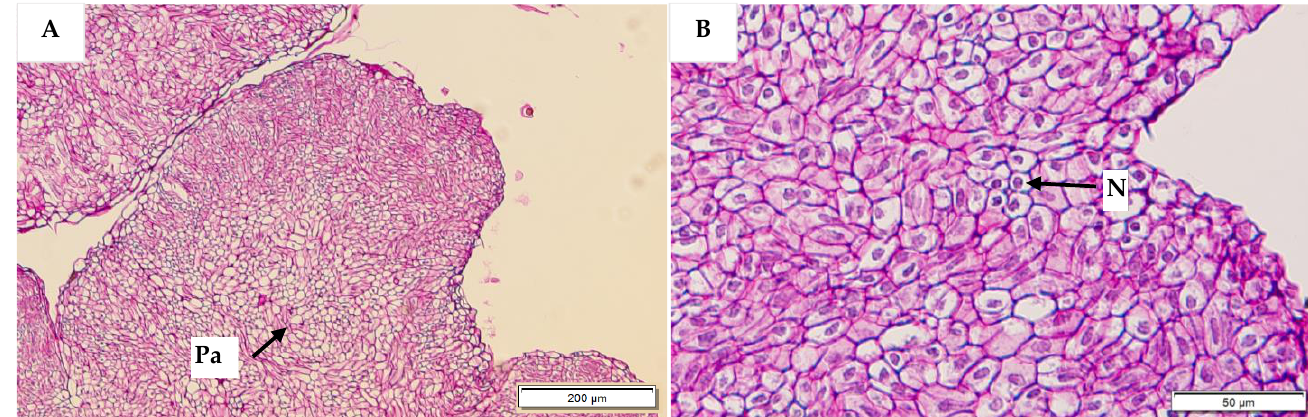
Figure 11. Histological sections of non-embryogenic callus stained with periodic acid Schiff’s reagent. Parenchyma (Pa) cells were observed in the central zone ( A ) at a magnification of 200 µm. No starch granules or meristematic cells were observed, under high resolution ( B ), but nuclei (N) were visible.